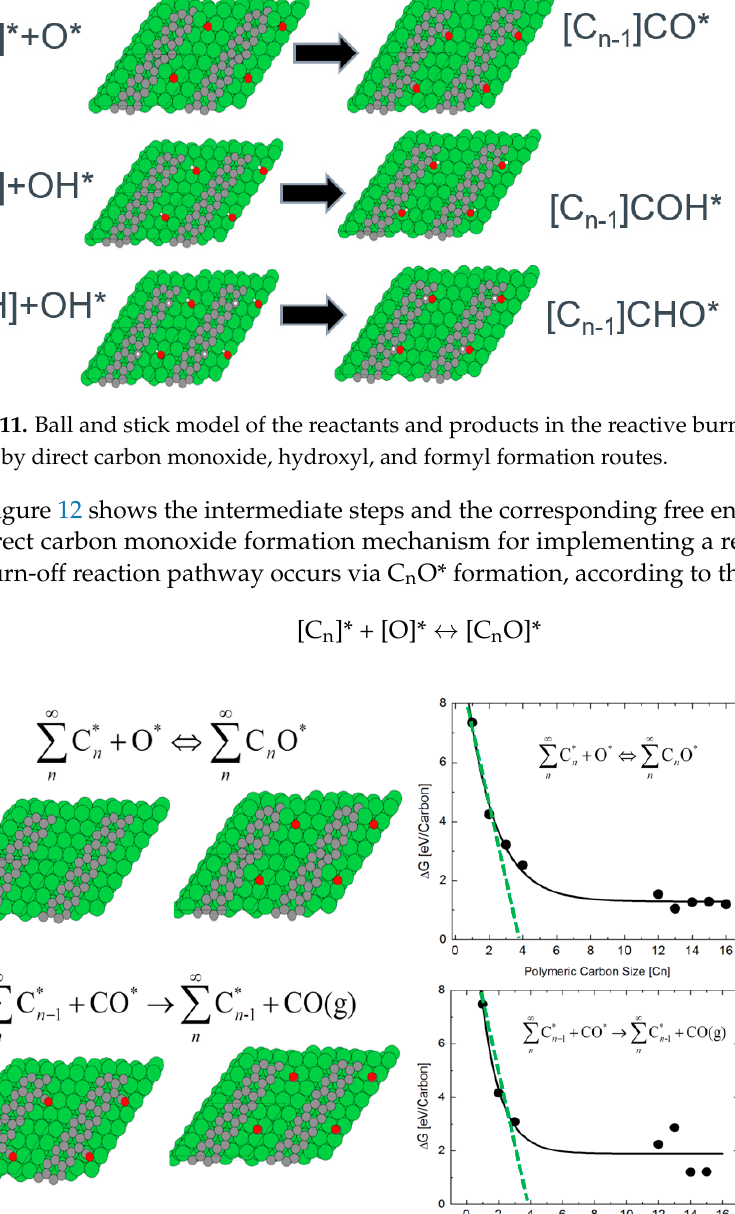
Figure 11. Ball and stick model of the reactants and products in the reactive burn-off of polymeric carbon by direct carbon monoxide, hydroxyl, and formyl formation routes.